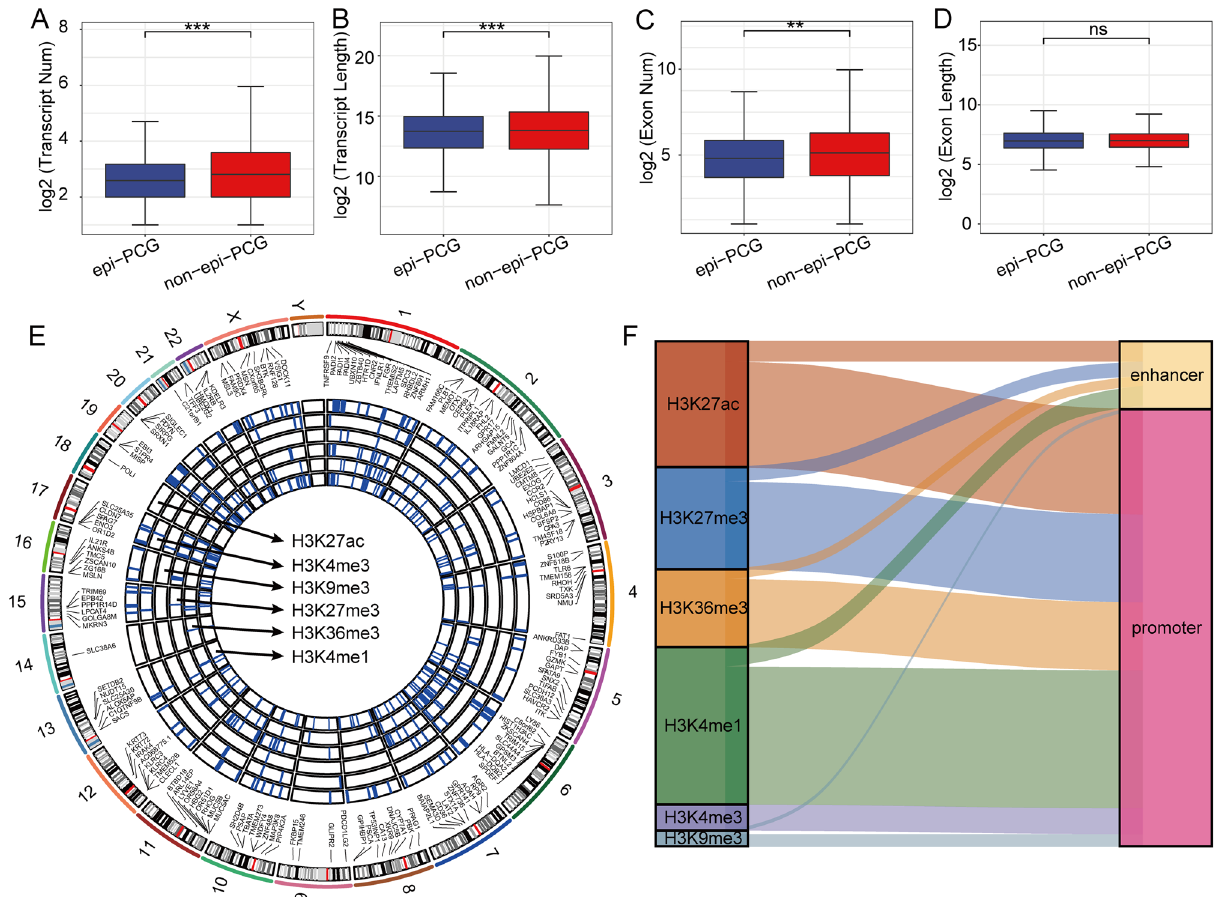
Figure 1. Genomic landscape of epigenetically dysregulated protein-coding genes (PCGs). ( A ) The number of epi-PCG transcripts was significantly lower than that of non-epi-PCG transcripts. ( B ) The length of epi-PCG transcripts was smaller than that of non-epi-PCG transcripts. ( C ) Epi-PCGs had a smaller number of exons than non-epi-PCGs. ( D ) The exons were not different in length between epi-PCGs and non-epi-PCGs. ( E ) Genomic landscape of epi-PCGs induced by different histone modifications. ( F ) Type distribution of dysfunctional epi- PCGs. (* P < 0.05; ** P < 0.01; *** P <